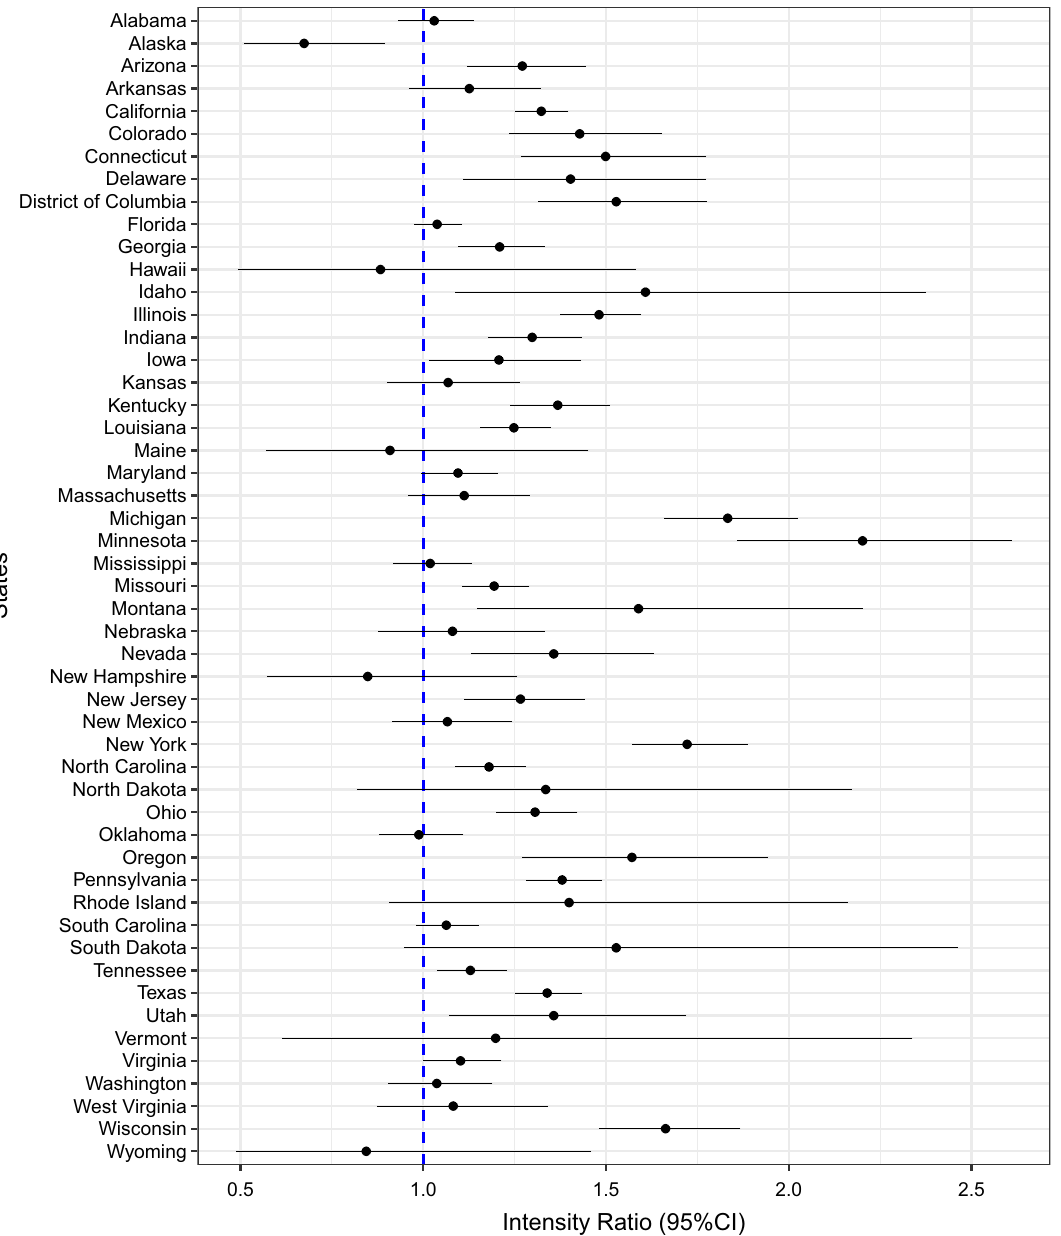
Figure 2. State-specific intensity of GV during and before the pandemic . State-specific intensity ratio (IR) and their 95% confidence intervals of GV. The dashed blue line in the forest plots represents the null estimate. IR greater than one indicates higher intensity of GV during the COVID-19 pandemic compared to the pre- pandemic